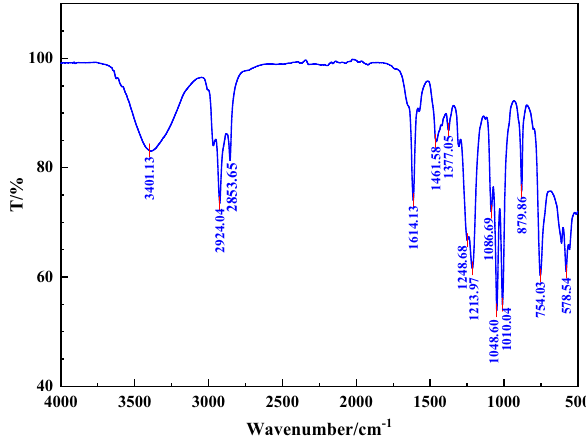
Figure 3: FT - IR analysis of emulsi fi er nano - SiO 2